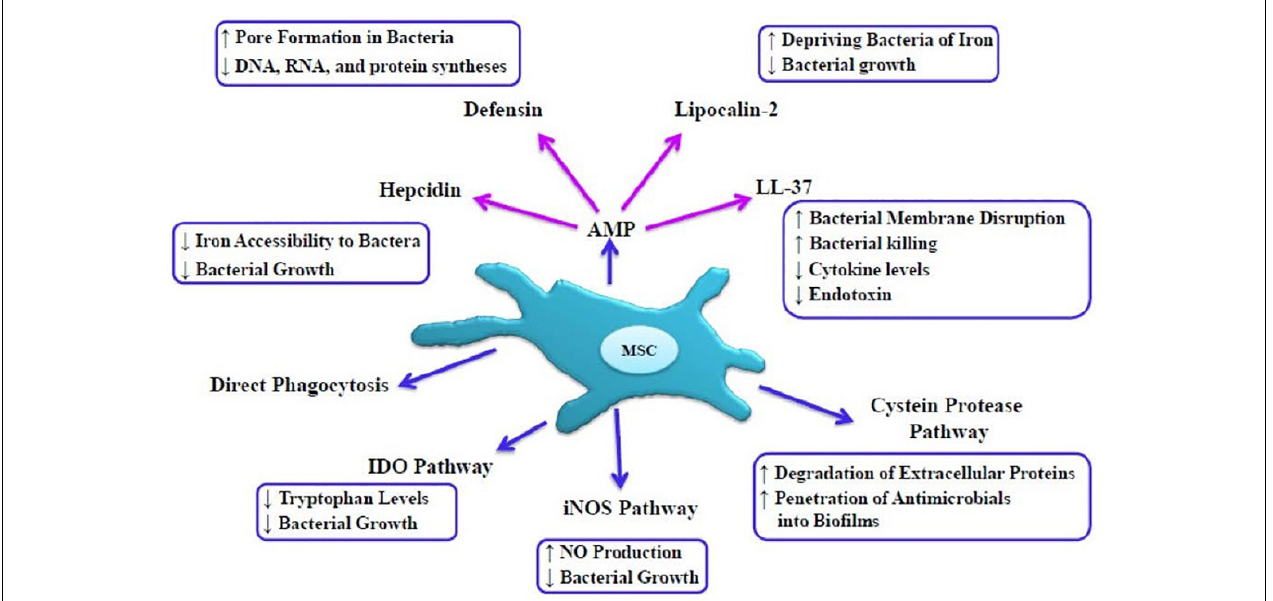
FIGURE 1 | Direct mechanisms of MSC-mediated bacterial killing, MSC exert direct antibacterial effects due to host defense peptides or AMPs. MScs can mediate bacterial killing by disrupting the integrity of the bacterial membrane, creating pores in the bacterial membrane, preventing of iron uptake, inhibiting biofilm formation, depleting tryptophan in microorganisms, and halting the growth of bacteria. IDO pathways, Indoleamine 2,3 dioxygenase; iNOS pathways, inducible nitric oxide synthase; NO, nitric